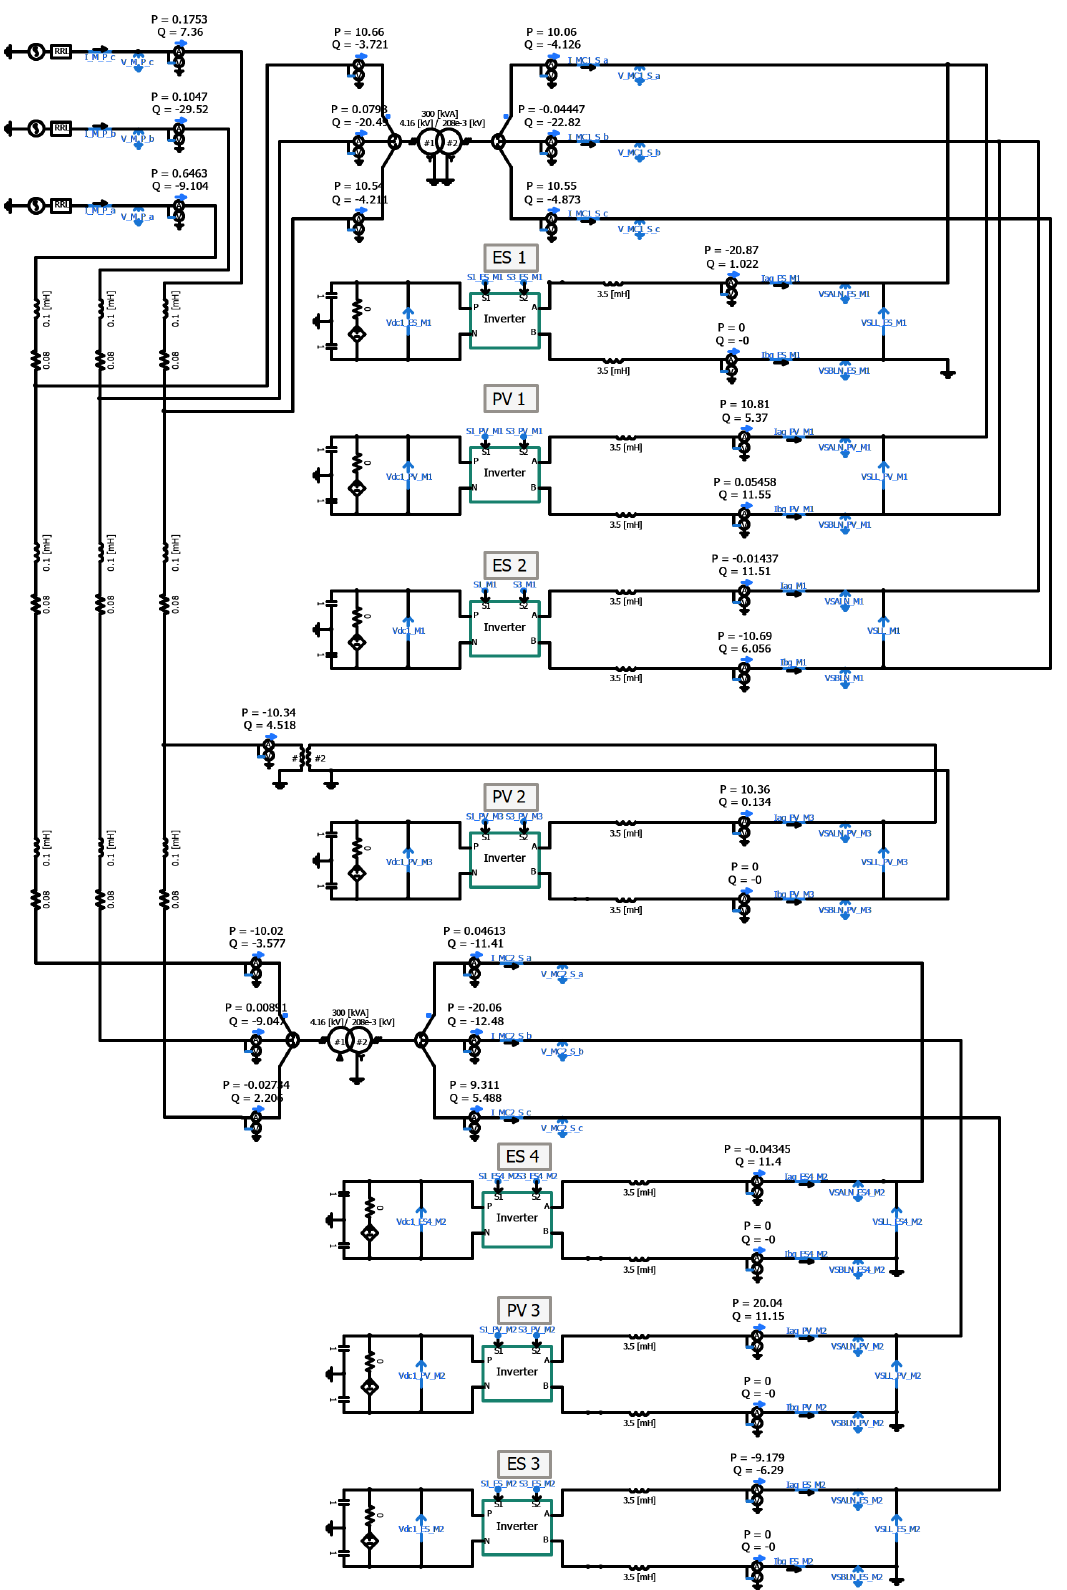
Figure 17. PSCAD simulation shows the active and reactive power flow (in kW and kvar) of the multimicrogrid system after all power routing actions. (1) Within MC2, 10 kW from PV3 (phase B) is routed to ES3 (phase C), (2) 10 kW from PV2 in MC3 (phase C) is routed to charge ES2 in MC1 (on phase B-C), and (3) 10 kW from PV3 in MC2 (phase B) and 10 kW from PV1 in MC1 (phase A-B) are routed to charge ES1 in MC1 (phase